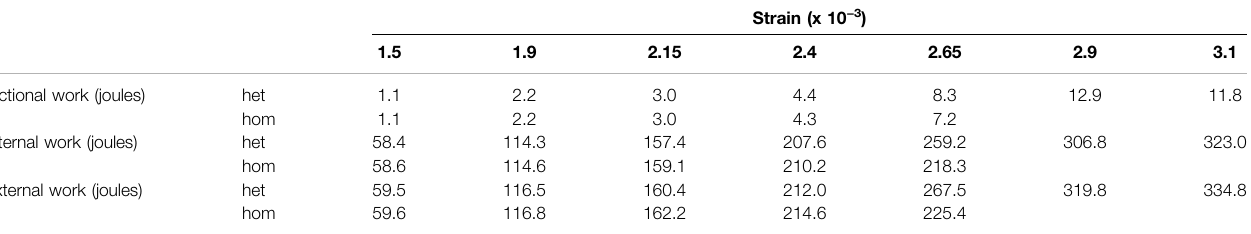
TABLE2| Energybudgetvaluesforhomogeneousandheterogeneousmodels.Thehomogeneousmodelreachedfailureatastrainof2.65e-3andthereforeenergybudget values are not reported for higher strains.